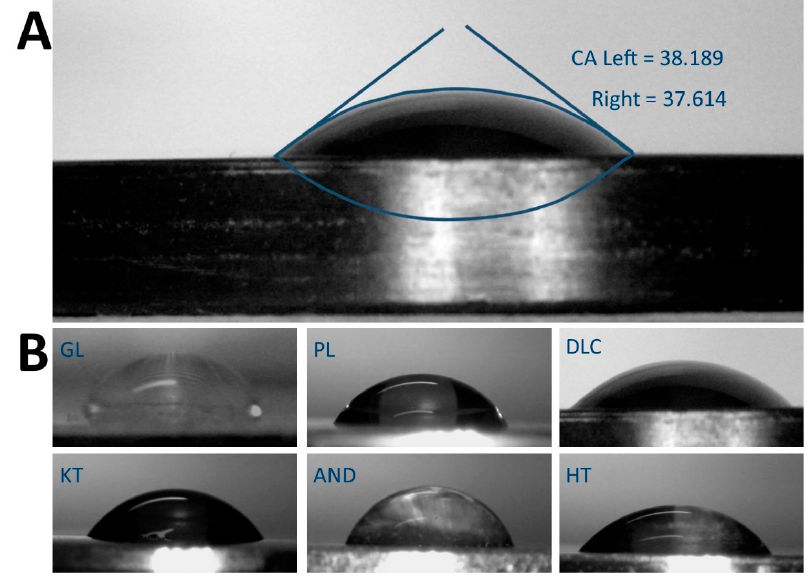
Figure 2. ( A ) Example of sessile water drop contact angle (CA) measurement on a freshly-cleaned DLC-treated surface using Dropsnake. ( B ) Water drops on all measured surfaces – reference glass coverslips (GL) and Ti6Al4V samples modified by polishing (PL), by DLC-coating (DLC), by brushing (BR), by anodizing (AND), and by blasting